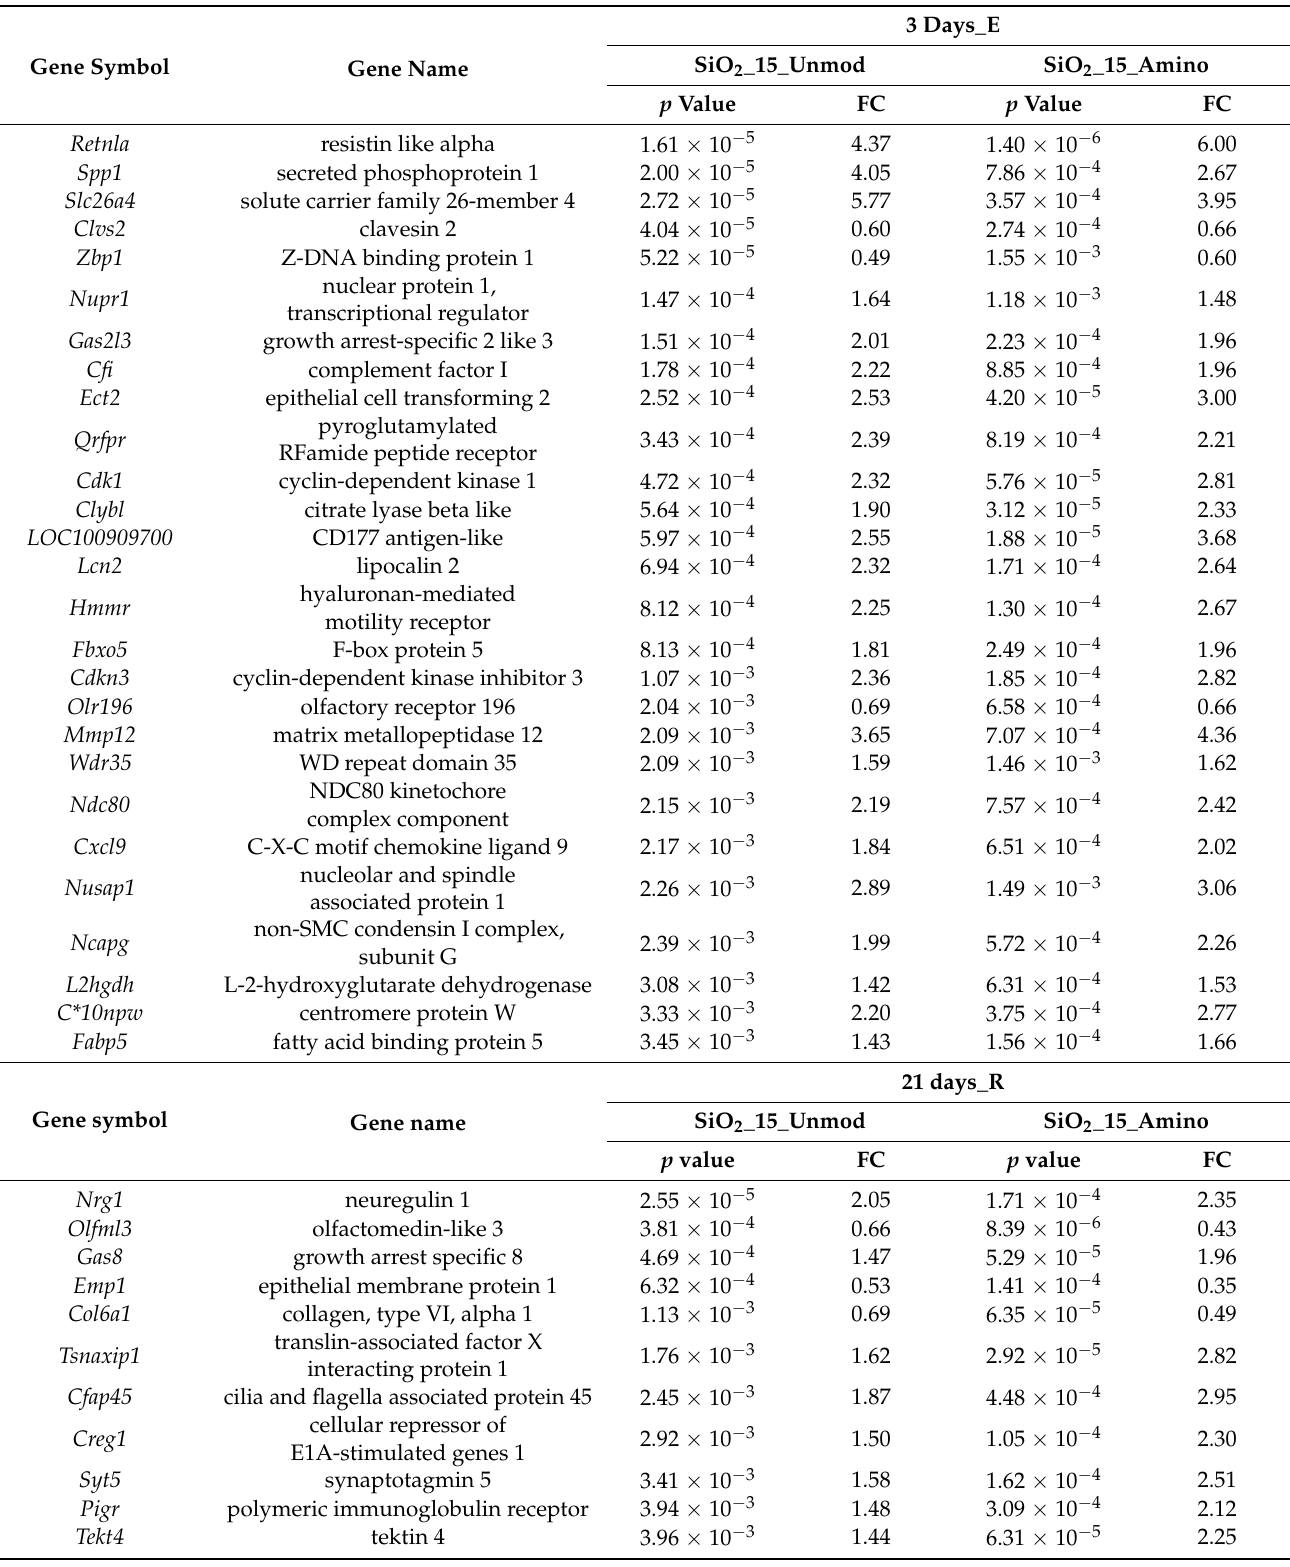
Table 5. Lung gene expression changes shared by rats exposed by instillation to SiO 2 _15_Unmod and SiO 2 _15_Amino.